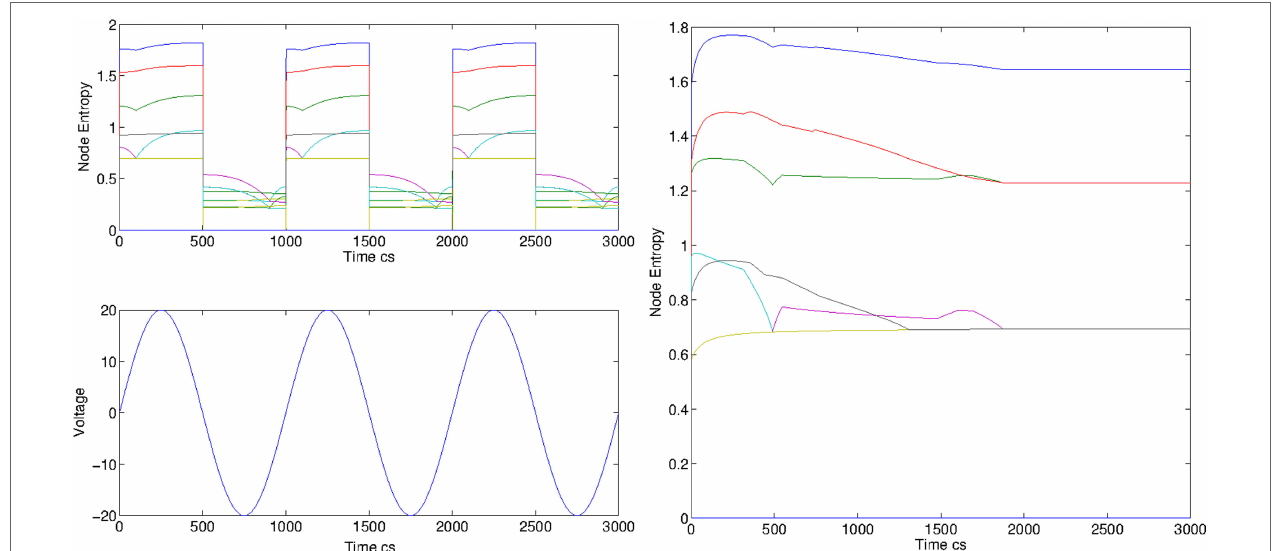
FIGURE 3 | Evolution of the node entropy for AC and DC voltage, measured in centiseconds for random initial conditions for L =4 . Left: evolution of the entropy for the tree graph of Figure 2 when an AC voltage is applied to the network with V = 20 sin(10 t ) volts. Right: entropy evolution for the tree graph of Figure 2 for a DC voltage V =